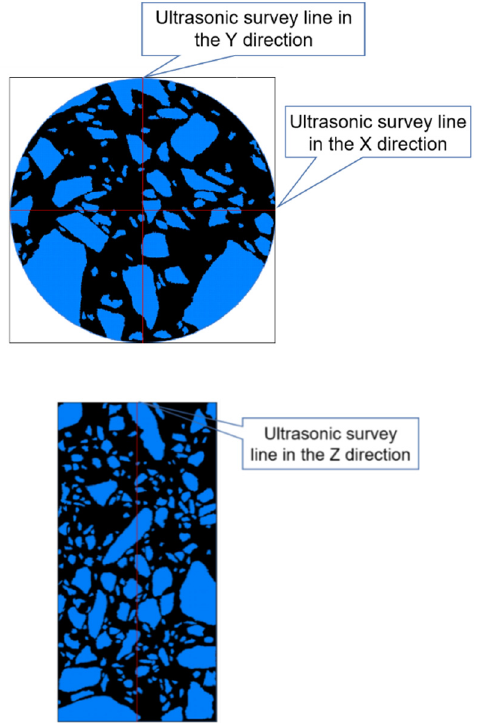
Figure 8. Correspondence between the ultrasonic survey line and the CT image.